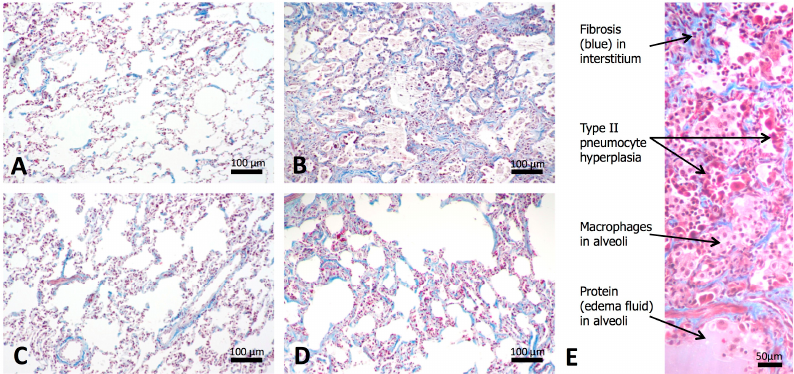
Figure 7. Histologic appearance of lung tissue in ( A ) sham-irradiated, saline-treated controls, ( B ) irradiated animals with no hexyl treatment, ( C ) sham-irradiated animals given hexyl treatment, and ( D ) irradiated animals given hexyl. Trichrome stain. ( E ) Higher-magnification